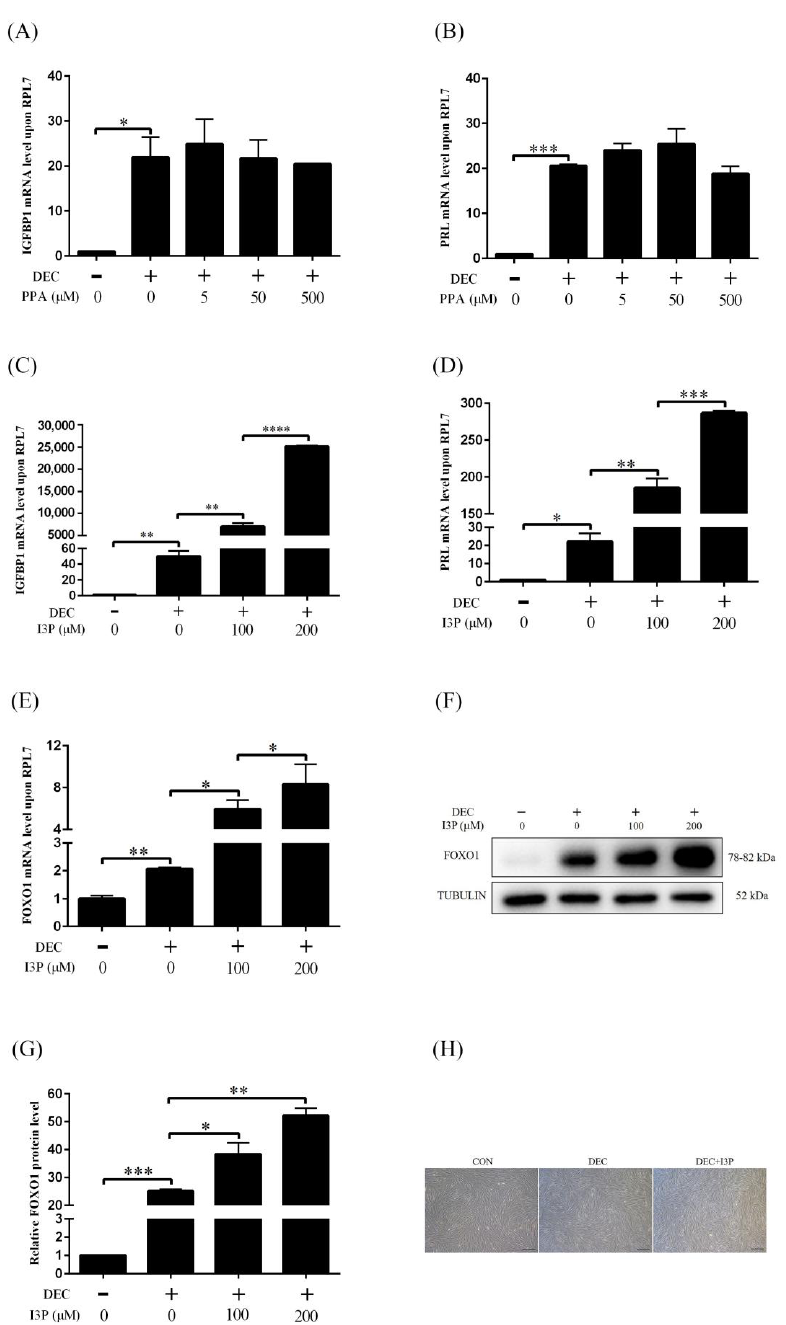
Figure 1. The effects of I3P on human in vitro decidualization. ( A ) RT-qPCR analysis on effects of different concentrations of PPA on IGFBP1 mRNA level under in vitro decidualization for 4 days. ( B ) Effects of different concentrations of PPA on PRL mRNA level under in vitro decidualization for 4 days. ( C ) RT-qPCR analysis on effects of different concentrations of I3P on IGFBP1 mRNA level under in vitro decidualization for 4 days. ( D ) The effects of different concentrations of I3P on PRL mRNA level under in vitro decidualization for 4 days. ( E ) Effects of different concentrations of I3P on FOXO1 mRNA level under in vitro decidualization for 4 days. ( F , G ) Western blot analysis of the protein level of FOXO1. ( H ) Effects of 200 µ M I3P on the morphology of human endometrial stromal cells under in vitro decidualization for 4 days. Scale bar = 20 µ m. CON, control; DEC, decidualization; PPA, phenylpyruvic acid; I3P, indole-3-pyruvic acid. *, p < 0.05; **, p < 0.01; ***, p < 0.001; ****, p <